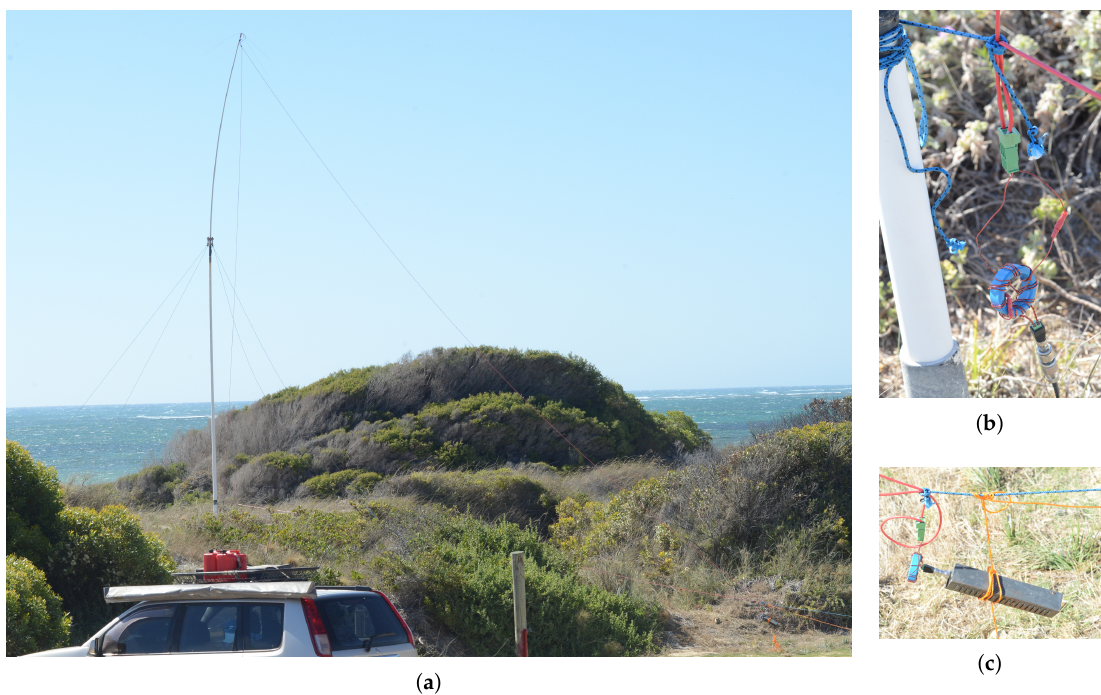
Figure 2. Lancelin field trial of TWLA prototype. The overall TWLA prototype is shown in ( a ). ( b ) shows the unbalanced-unbalanced transformer matching feed arrangement. ( c ) shows the 8:1 balanced-unbalanced transformer and commercial 1 kW test